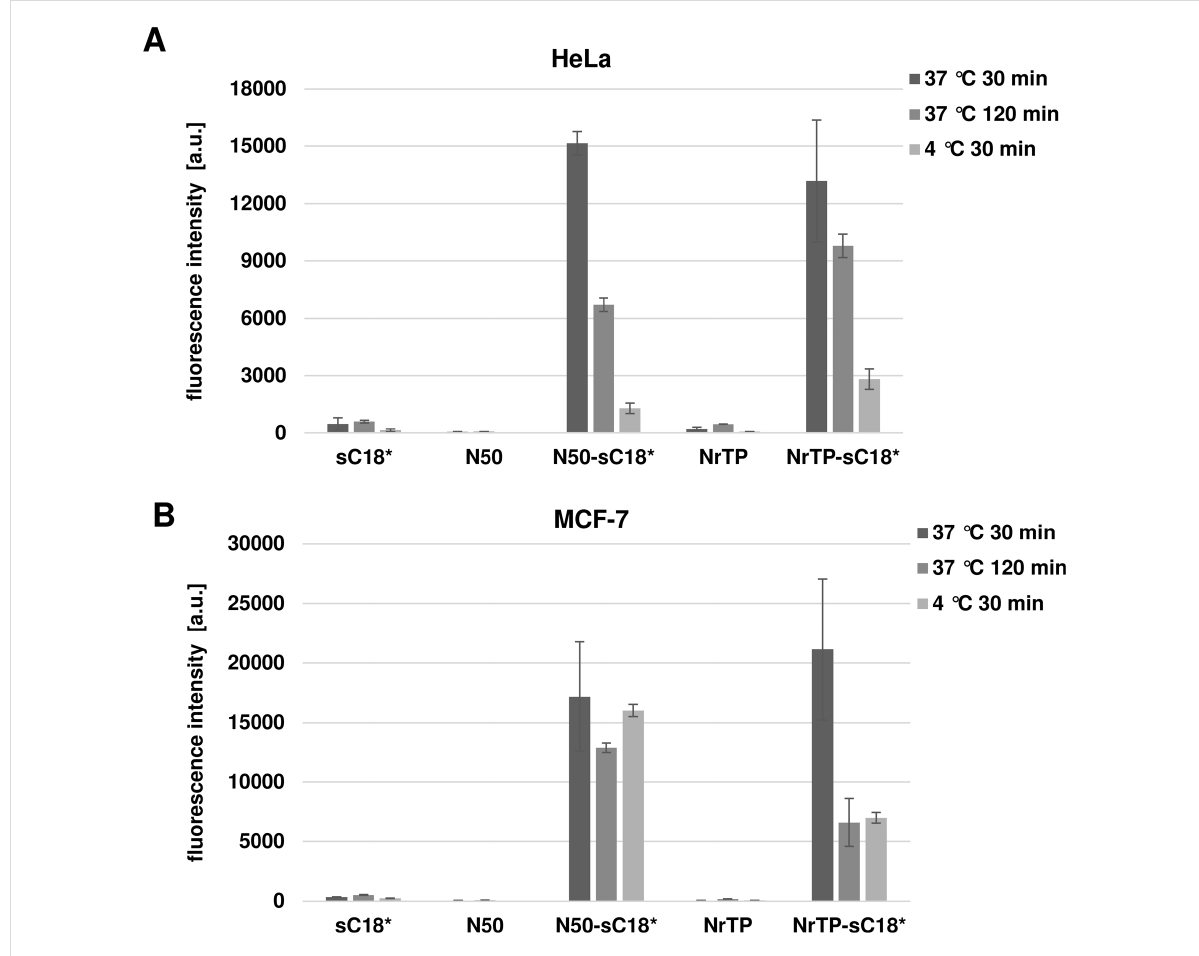
Figure 4: Cellular uptake in MCF-7 and HeLa cells was quantified by flow cytometry. Cells were incubated with 10 µM peptide solutions for 30 min at 37